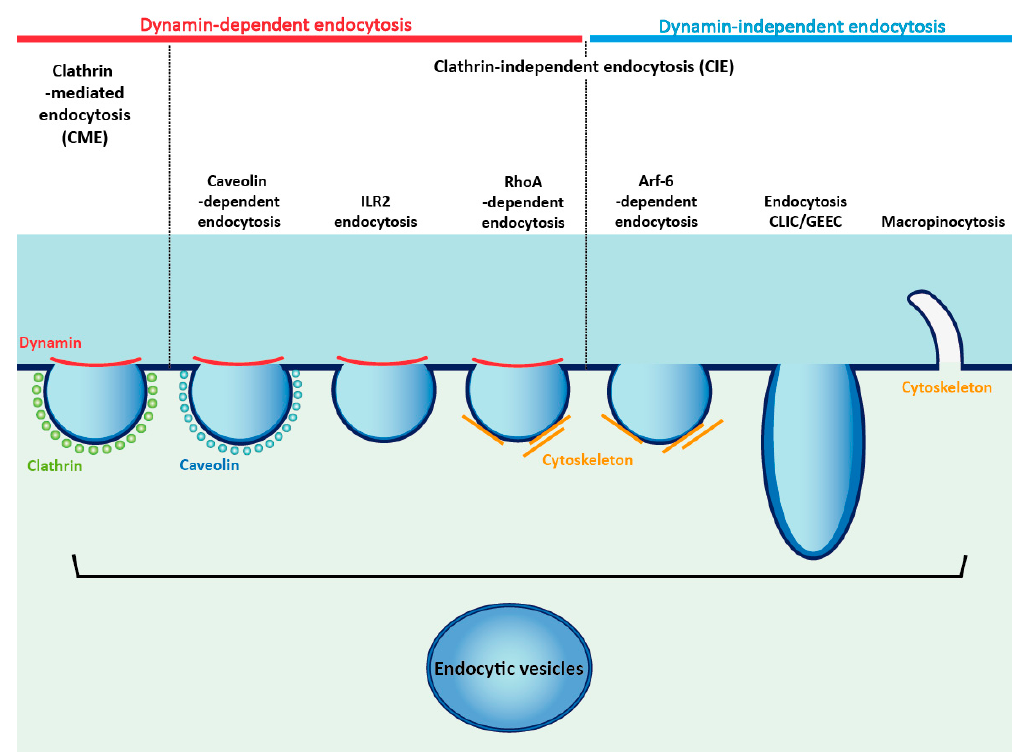
Figure 3. Cellular internalization pathways utilized by RTKs. Endocytic pathways may involve dynamin, or may be independent of this protein. Various mechanisms lead to the formation of intracellular endocytic vesicles containing RTKs (for details, see main text of the manuscript). FGFRs undergo constitutive internalization from the plasma membrane. However, the binding of the FGFs and the subsequent receptor activation stimulates FGFRs endocytosis [141–144]. Depending on the ligand and FGFR isoform, different endocytic pathways are engaged in FGFRs internalization (Figure 4). However, FGFRs mainly utilize CME as a way to reach the cellular interior [142,144].